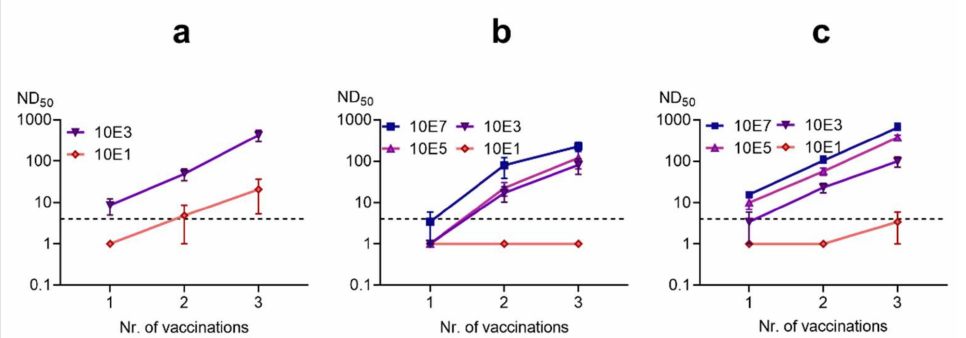
Figure 6. Titration of vaccine doses: Neutralizing antibody titers in vaccinated rabbits. BoDV-1 live vaccine “Dessau” containing 10 3 FFU and 10 1 FFU per dose ( a ) were compared with batches of ethylenimine-inactivated BoDV-1 “Dessau” vaccines containing either ( b ) no adjuvant and 10 7 , 10 5 , 10 3 , 10 1 FFU BoDV-1 or ( c ) ISA25 (mineral oil-based o/w) adjuvant and 10 7 , 10 5 , 10 3 , 10 1